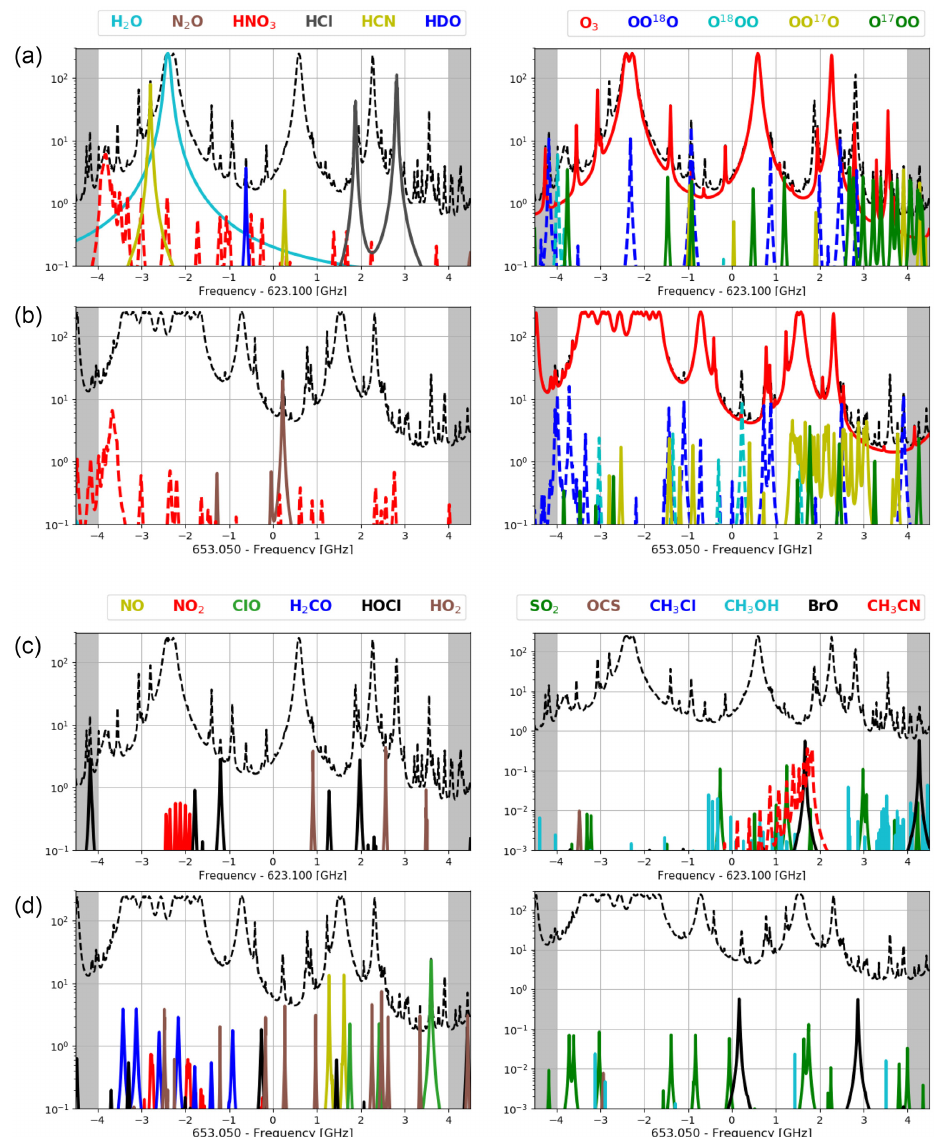
Figure 3. Contributions of the most relevant chemical species to the SIW spectrum. More that 20 molecules are shown in four groups of two panels. In each group, the upper panel shows the lower sideband spectrum (dashed black lines) with a central frequency of 623.1GHz and the lower panel shows the upper sideband spectrum with a central frequency of 653.05GHz. The colored lines are single-molecule spectra. Grey-shaded areas are outside the bandwidth. The tangent height is 35km and frequencies are ordered according to the intermediate frequencies. The intensity is given in brightness temperature ( y